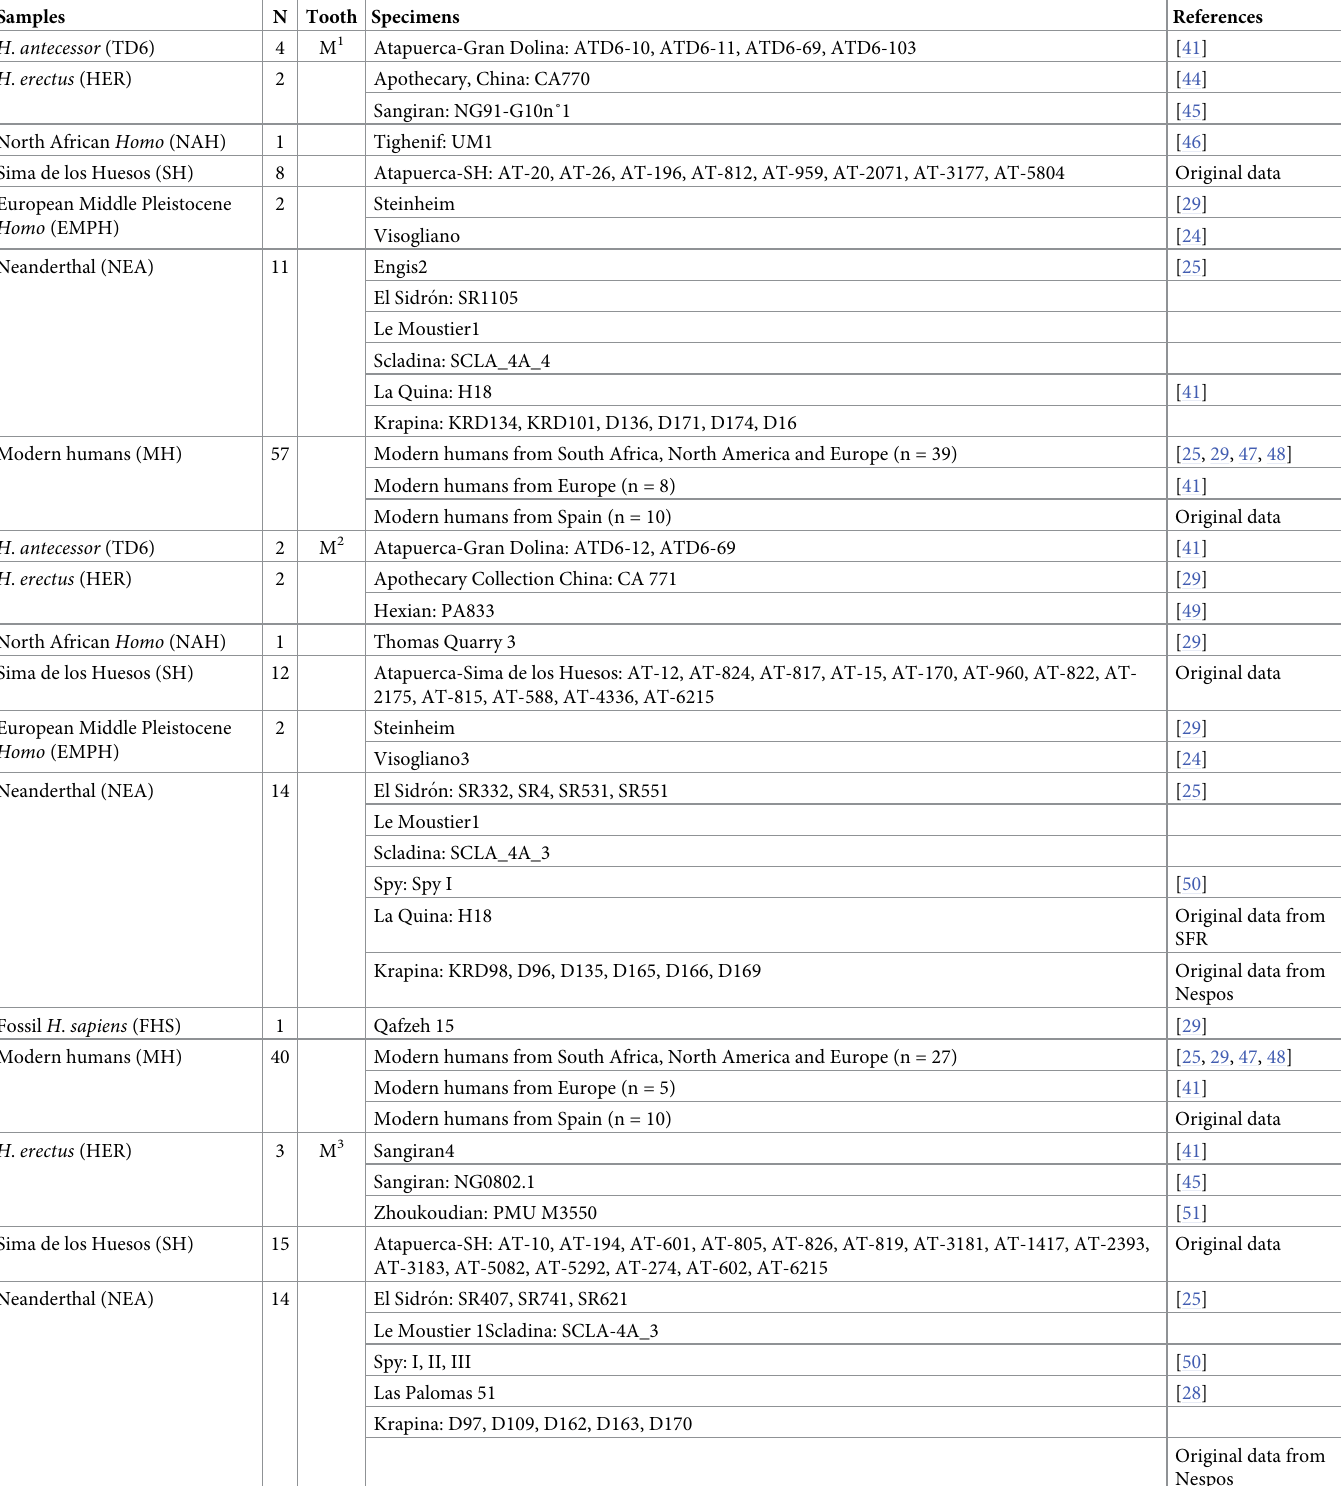
Table 1. Fossil and recent comparative samples used for crown 2D and 3D complete crown and lateral 3D measurements.